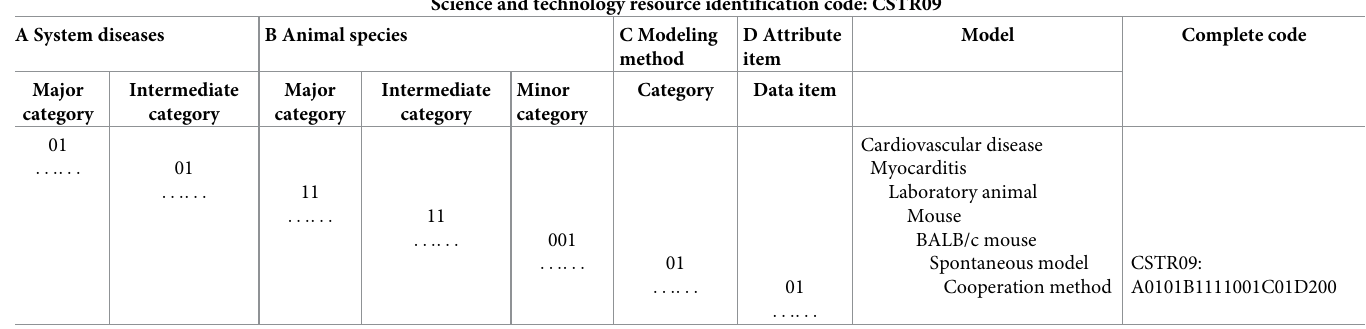
Science and technology resource identification code: